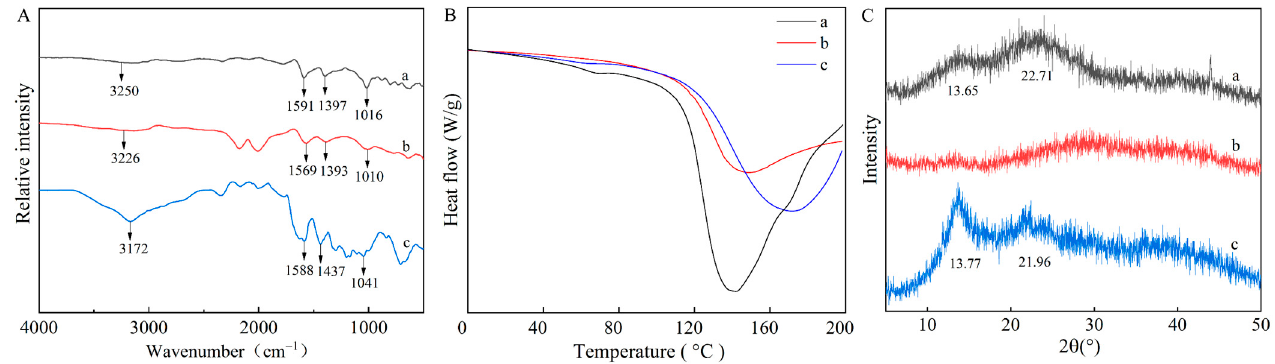
Figure 4. Macro-morphology of empty hydrogel ( A ) and MeSA hydrogel ( B ); SEM images of empty hydrogel ( C ) and MeSA hydrogel ( D ).